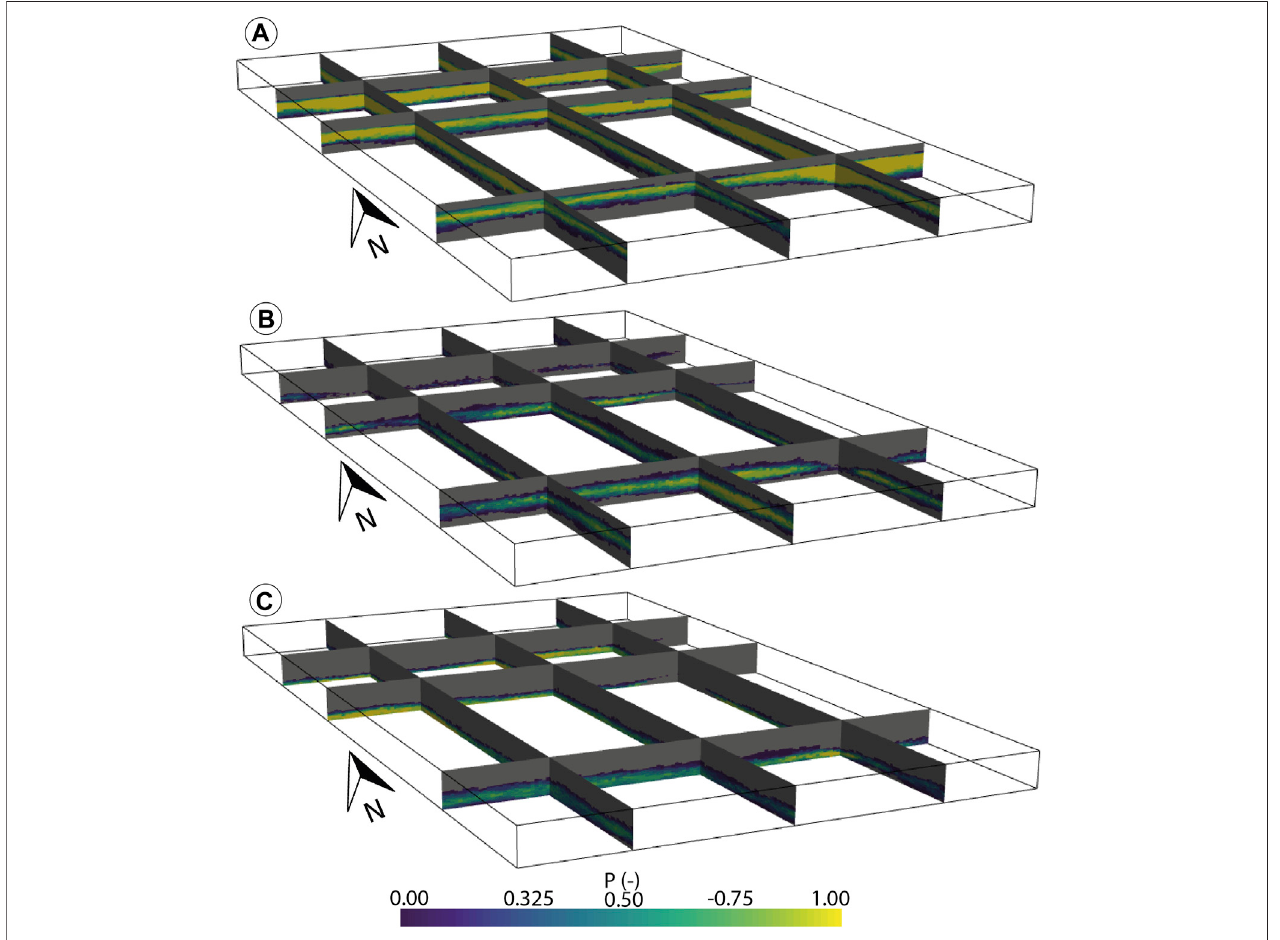
FIGURE 10 | Probability of occurrence along the 100 models for units YG (A) , LGA (B) , and LGL (C) . Vertical exaggeration = 3x.